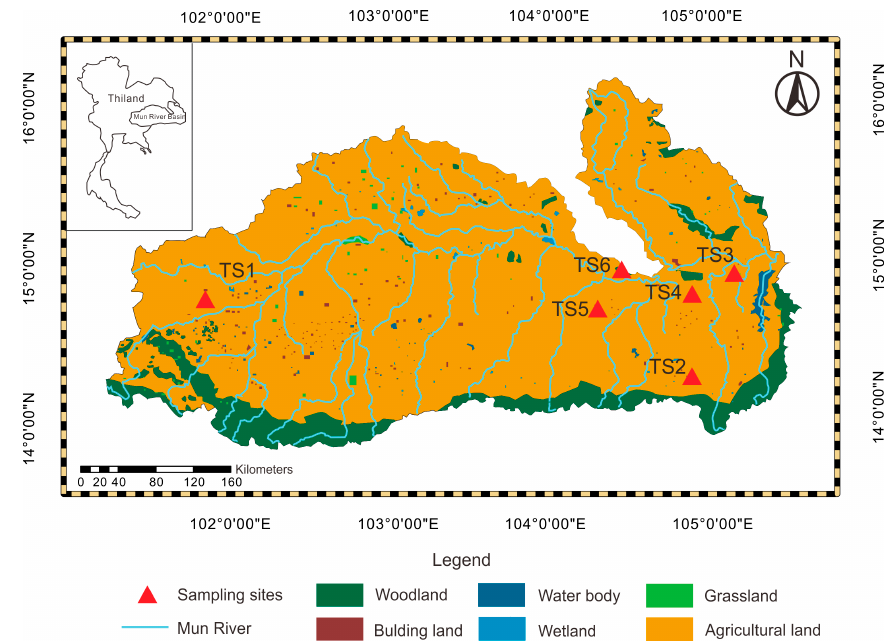
Figure 1. Land use types and locations of sampling sites in the study area.